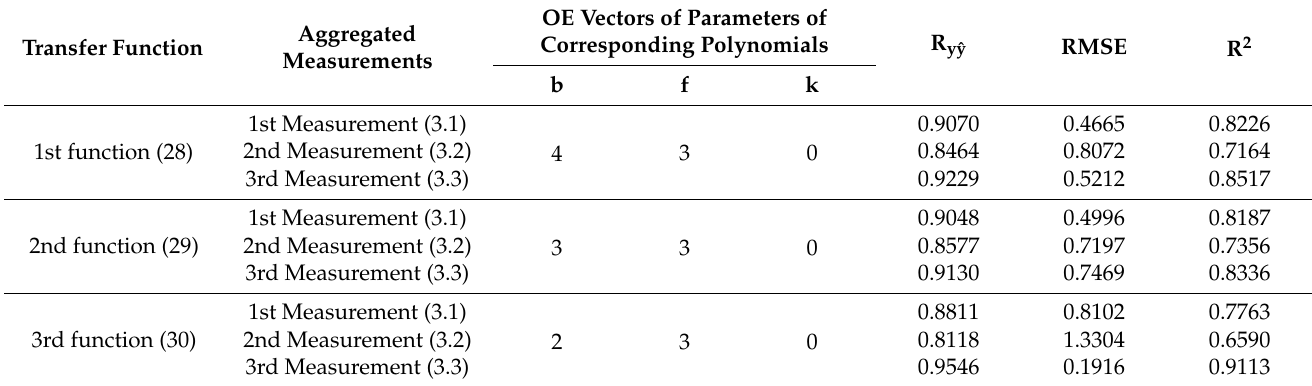
Table 3. R yˆy , RMSE, and R 2 coefficients of continuous transfer functions obtained by the OE model, when aggregated Measurements (3.1, 3.2, and 3.3) were